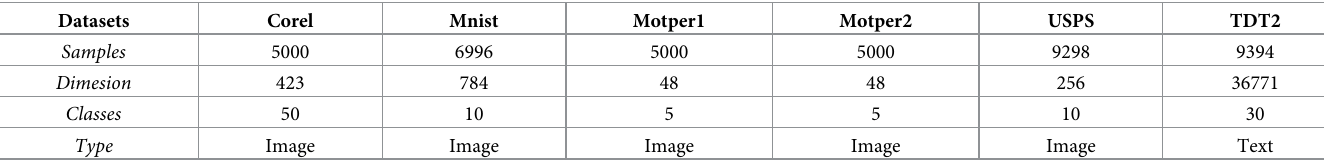
Table 1. Datasets